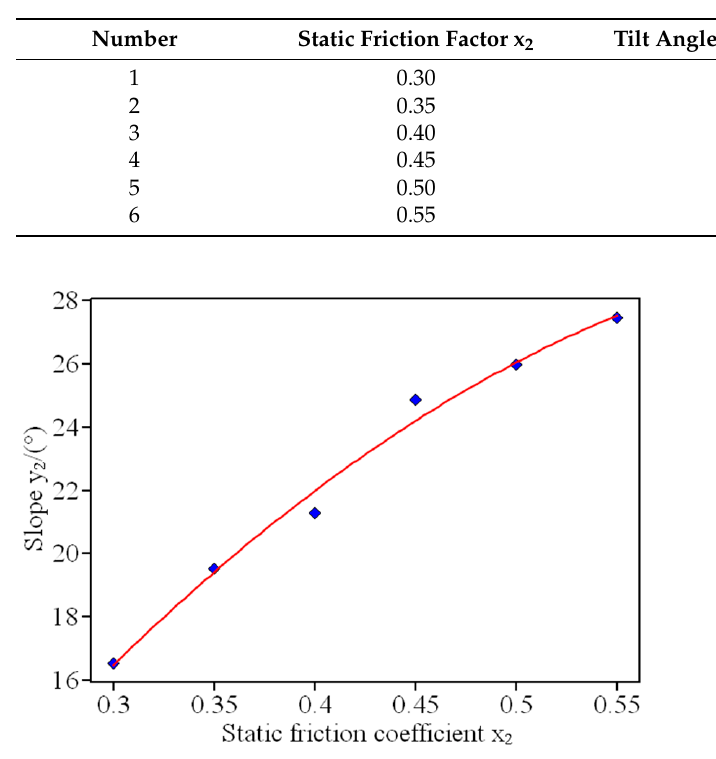
Figure 6. The fitting curve of inclination angle and static friction coefficient in the simulation exper-